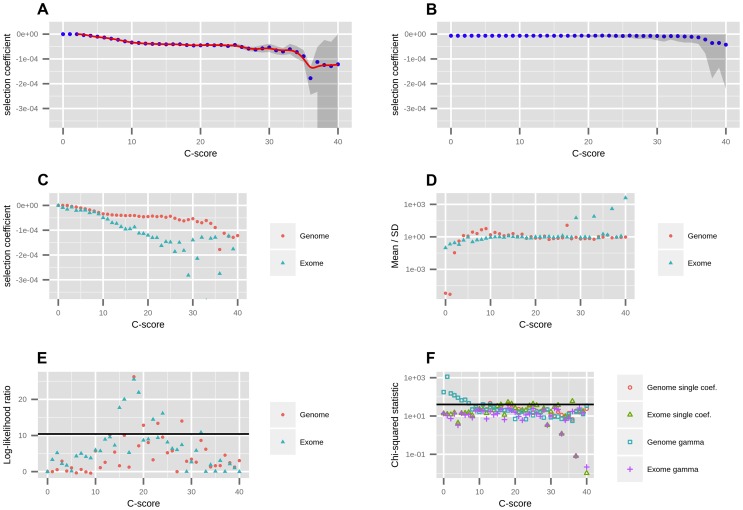
Mapping of C-scores to selection coefficients.A) We first fit a single coefficient to each bin using data from all autosomes in the genome. Red dots represent the maximum likelihood selection coefficient corresponding to each C-score bin. The blue line is a smooth spline fitted to the discrete mappings of C-scores to log-scaled selection coefficients after excluding the neutral bins (degrees of freedom  = 20). The grey shade is a 95% confidence interval obtained from bootstrapping the data 100 times in each bin. B) To verify the shape of the mapping was not a result of the number of sites in each bin, we randomized the C-score labels across polymorphisms, and recomputed the mapping. C) To account for exonic patterns of conservation and background selection that may not have been captured by C-scores, we computed a mapping based solely on exonic sites. D) We fitted gamma distributions of selection coefficients to each bin, and computed the mean divided by the standard deviation of each distribution, which is indicative of its shape (see Results). E) To test whether the gamma distributions were a significantly better fit than the single-coefficient mapping, we computed log-likelihood ratio statistics of the two models at each bin. The black line denotes the Bonferroni-corrected significance cutoff. F) To test how well we were fitting the data at each bin, we computed chi-squared statistics of the fitted SFS to the observed SFS at each bin. The black line denotes the Bonferroni-corrected significance cutoff.